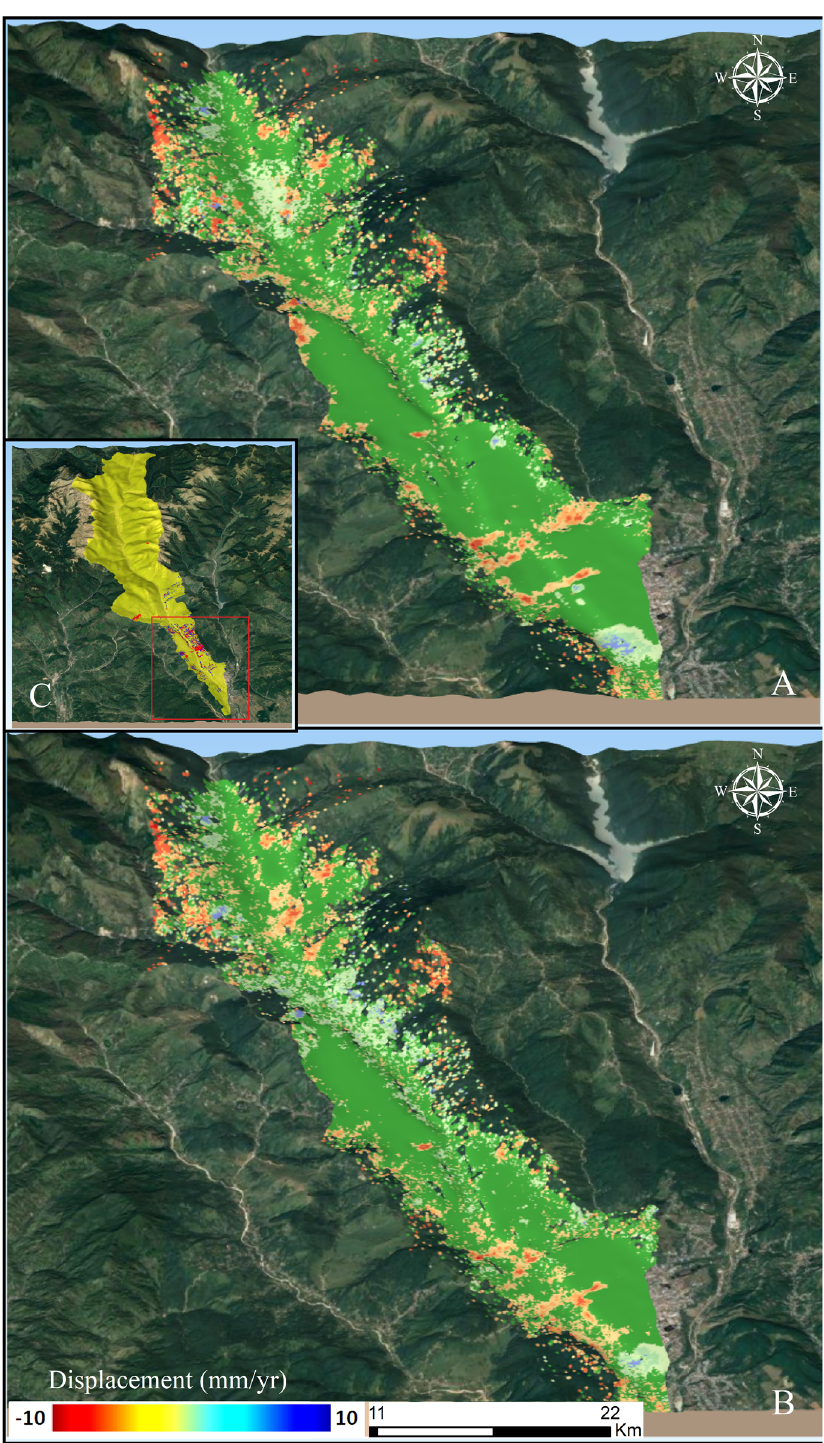
Figure 6. Deformation maps over the Subcarpathian area derived from Sentinel-1 data acquired on ( A ) ascending orbit and ( B ) descending orbit. Red dots show movement of the target away from the sensor, blue dots show movement towards the sensor and green points stable areas. ( C ) locates the Subcarpathian study area. Map created in QGIS3 software. Base map: Landsat 8 scene from 20 August 2019, downloaded from Earth Resources Observation and Science (EROS) Center, USGS.